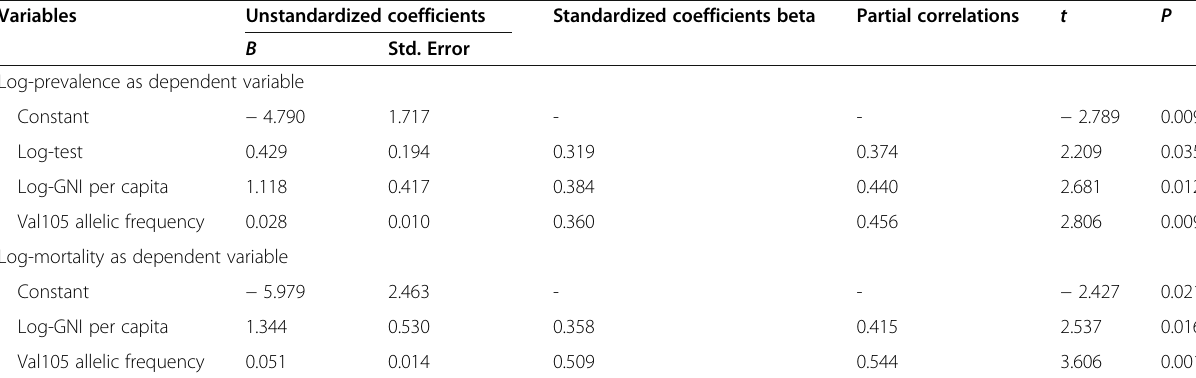
Table 4 Multivariable linear regression analysis for associations of log-mortality and log-prevalence of COVID-19 with the frequency of the Val105 allele in the various countries around the world in selected countries with GNI-per capita more than